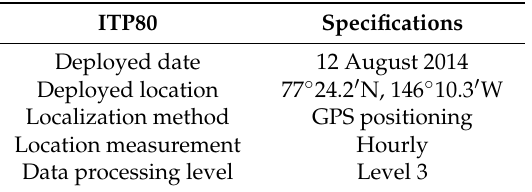
Table 3. Details for the ITP80 deployment and location record.